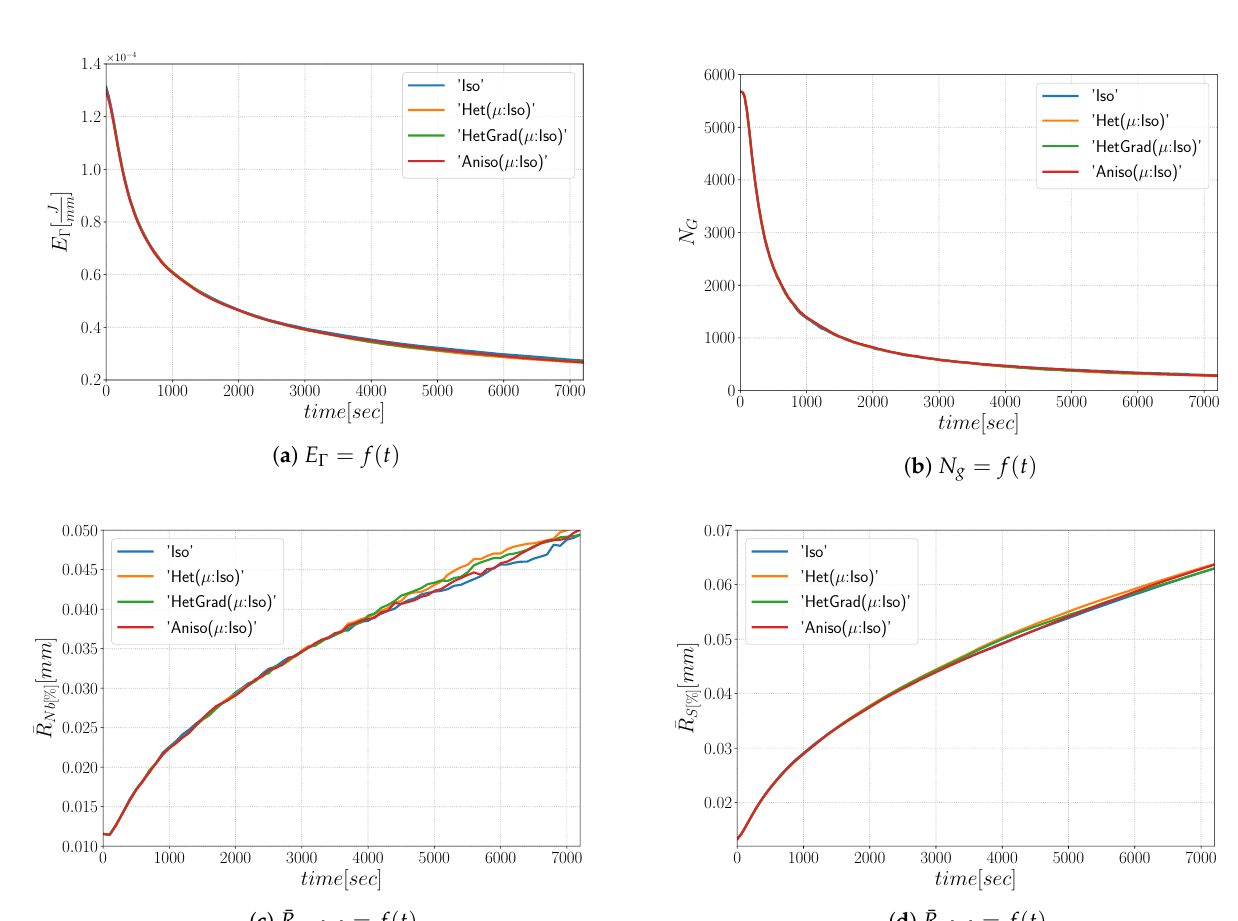
Figure 14. Time evolution for the different formulations: ( a ) the total GB energy, ( b ) the number of grains, ( c ) the mean radius weighted by number, and ( d ) the mean radius weighted by surface.